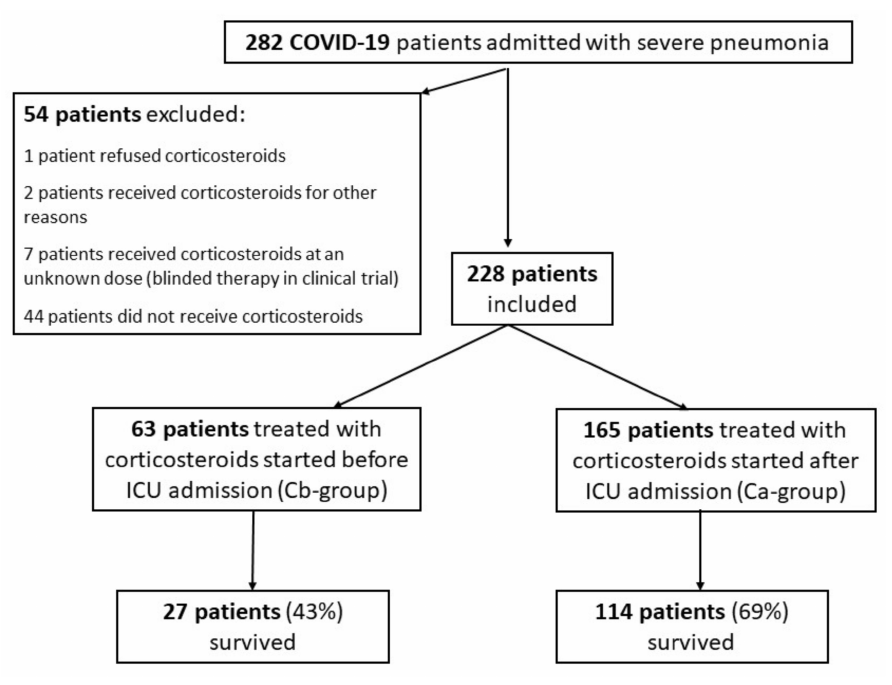
Figure 1. Flow chart of the study. Table 1. Characteristics and outcomes of the 228 critically ill COVID-19 patients according to the setting of corticosteroid therapy initiation, i.e., before (Cb-group) versus after (Ca-group) admission to the intensive care